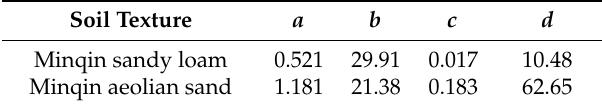
Table 2. Fitting parameter values of simplified model for Minqin sandy loam and aeolian sand. Soil Texture